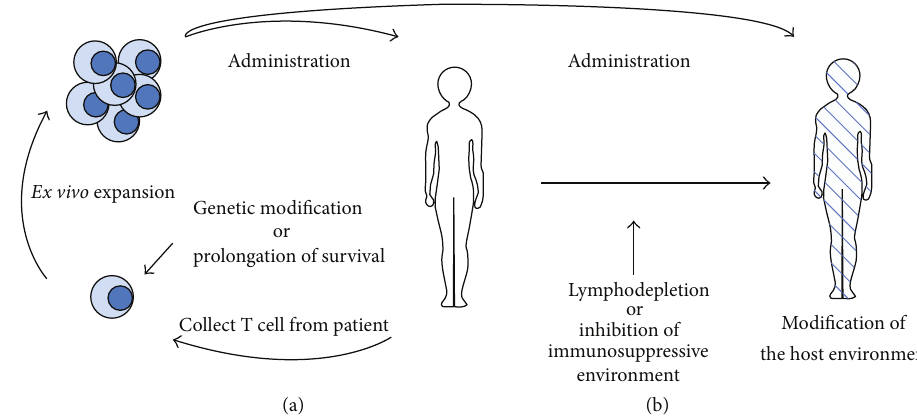
Figure 1: Adoptive T cell transfer therapy. (a) Enhancement of tumor-specific T cell function. (b) Modification of the host environment.